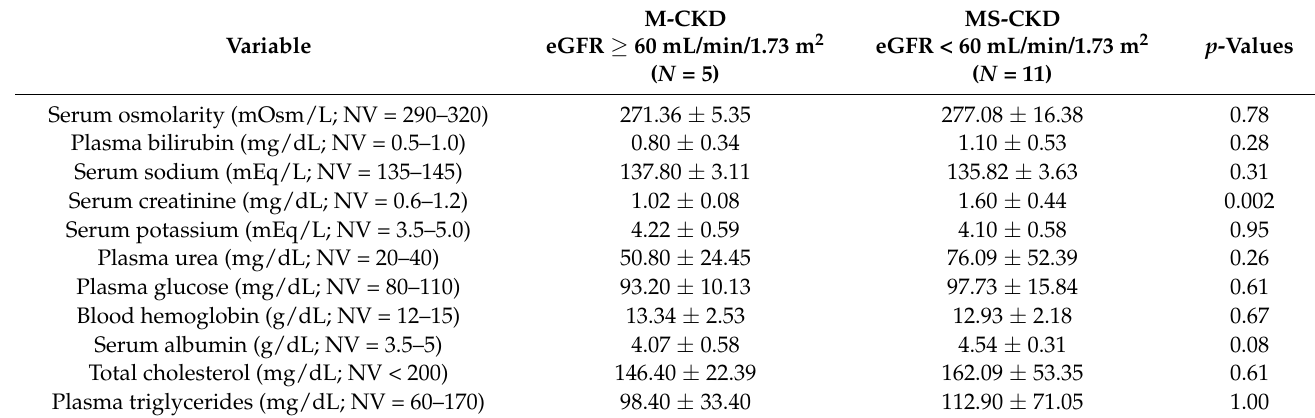
Table 9. Blood non-amino acid variables in mild CKD (M-CKD; eGFR ≥ 60 mL/min/1.73 m 2 ) and moderate-severe CKD (MS-CKD; eGFR < 60 mL/min/1.73 m 2 ) patients.